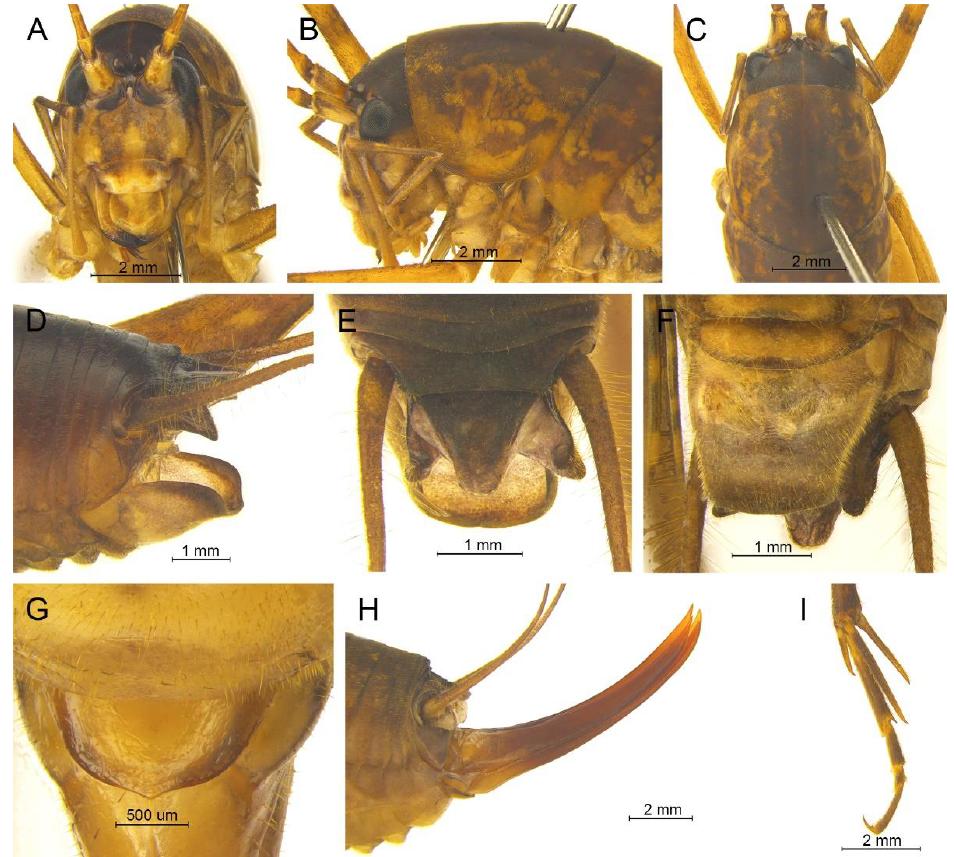
Figure 14. Pseudotachycines sagittus Zhu & Shi sp. nov., male: ( A – C ) head and pronotum: ( A ) frontal view, ( B ) lateral view, ( C ) dorsal view; ( D – F ) apex of abdomen: ( D ) lateral view, ( E ) dorsal view, ( F ) ventral view; ( I ) hind tarsus in lateral view; female: ( G ) subgenital plate in ventral view; ( H ) ovipos- itor in lateral view.